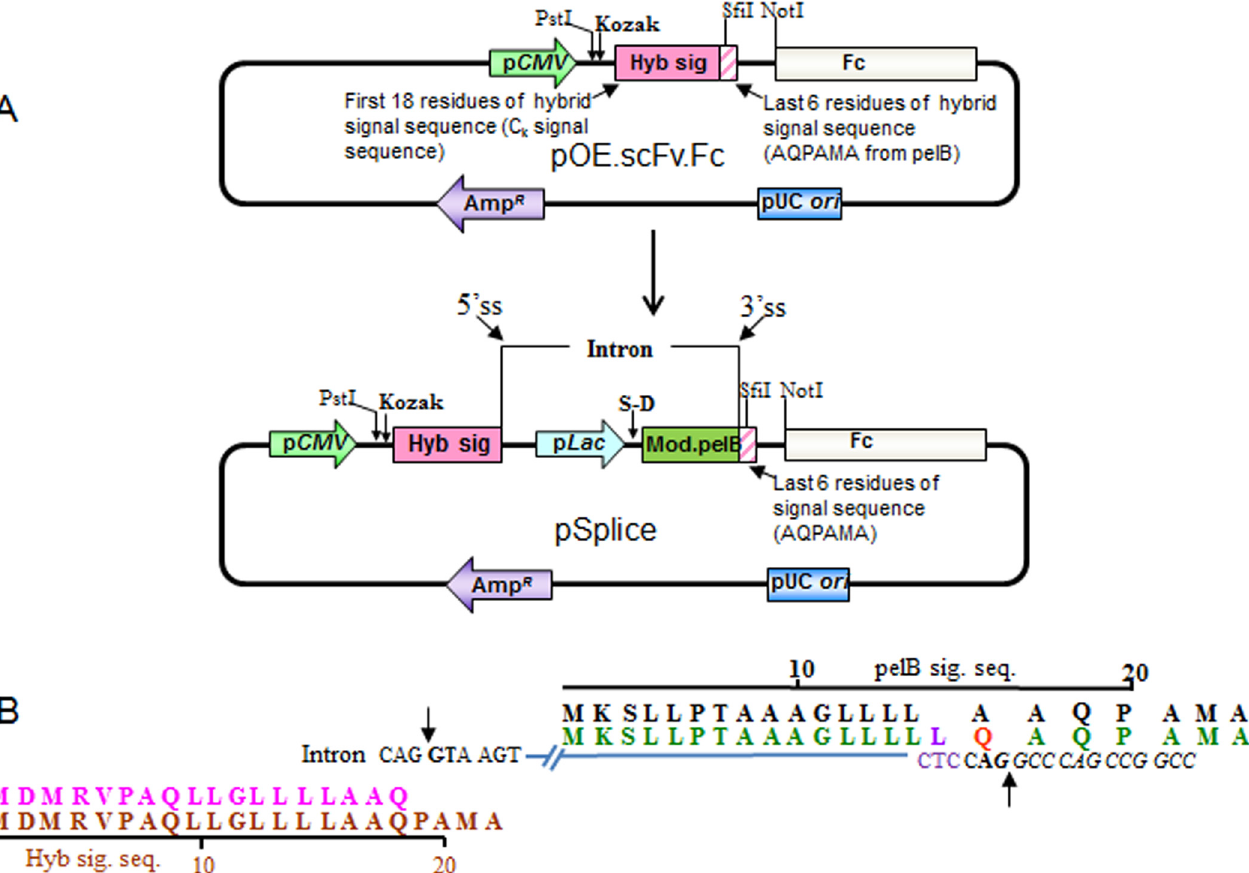
Fig 1. (A) Schematic representation of pSplice vector construction. pSplice is derived from pOE scFv.Fc vector. pOE scFv.Fc vector can express the fusion protein only in mammalian cells while pSplice vector can express the fusion protein both, in E . coli and mammalian cells. The hatched pink portion represents peptide sequence AQPAMA, which is common to the hybrid (Hyb sig) and the modified pelB (Mod pelB) signal sequences. Expression in the bacterial system is directed by the Lac promoter (light blue) and a modified pelB signal peptide (dark green followed by hatched pink), which are placed within an intron between the 5 ’ and 3 ’ splicing sites (ss). Production of scFv-Fc in 293F cells is controlled by CMV promoter (light green) and a hybrid signal peptide (solid pink followed by hatched pink) when the intron is spliced out in 293F cells. (B) Schematic representation of the intron and the main changes introduced in the signal sequences. In brown is the hybrid signal sequence of pOEscFv.Fc. In pink is the point where the open reading frame of hybrid signal sequence is disrupted by insertion of the intron (blue line). Bold letters (nucleotide sequence) and arrows in the intron represent the splice donor and acceptor sites. In black is the pelB signal sequence. Immediately below, in green is the modified pelB signal sequence. Within this peptide sequence an A to Q mutation is indicated in red. The corresponding codon creates the splice acceptor site. In magenta is an insertion of a leucine in pelB signal sequence. The corresponding codon creates a polypyrimidine site in the